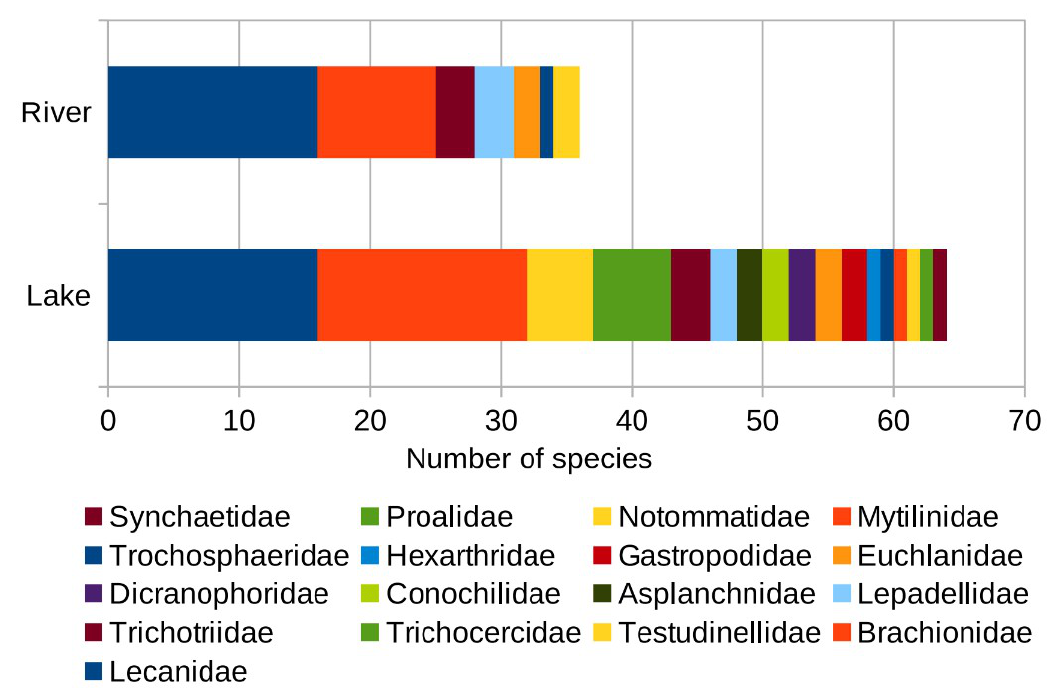
Figure 4. Rotifer community structure at the family level in lakes and rivers in Da Nang.